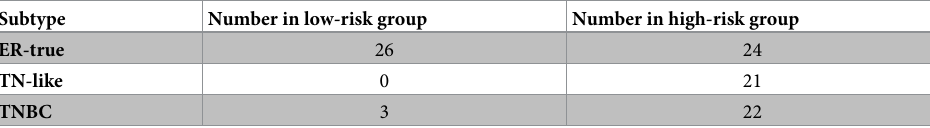
Table 3. Number of patients classified by the DMFS predictor into a low or a high-risk group.